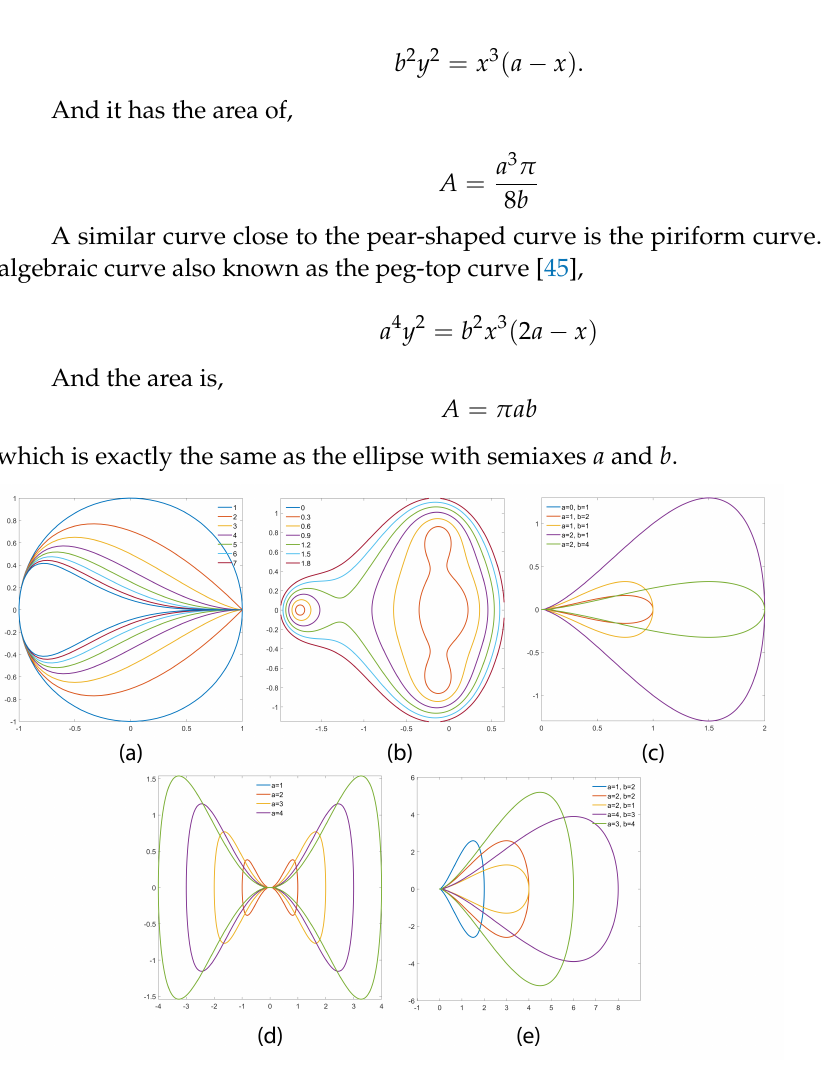
Figure 3. Different curves for the microbot’s body design ( a ) teardrop curve ( m = 1 − 7), ( b ) pear curve ( r varied from o to 1.8 with 0.3 interval), ( c ) pear-shaped curve (with varying a and b values), ( d ) dumbbell curve ( a = 1 − 4), and ( e ) piriform curve (with varying a and b